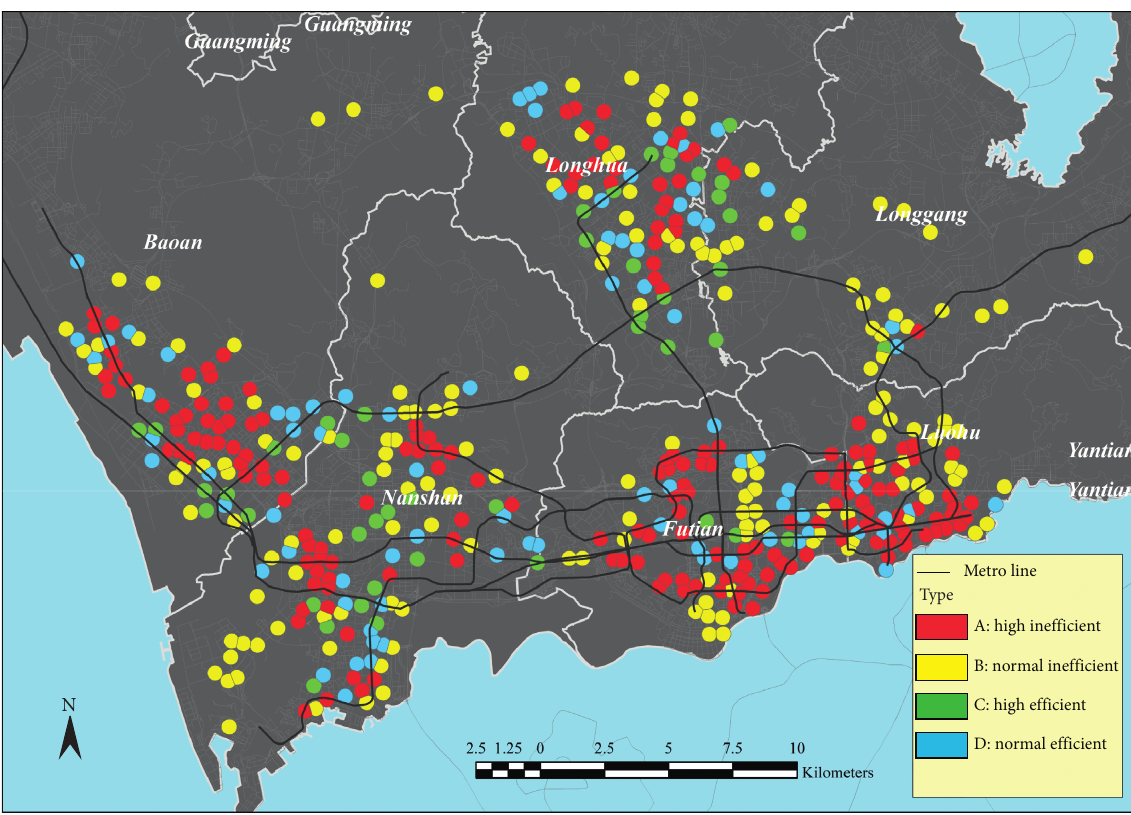
Figure 6: The distribution of four